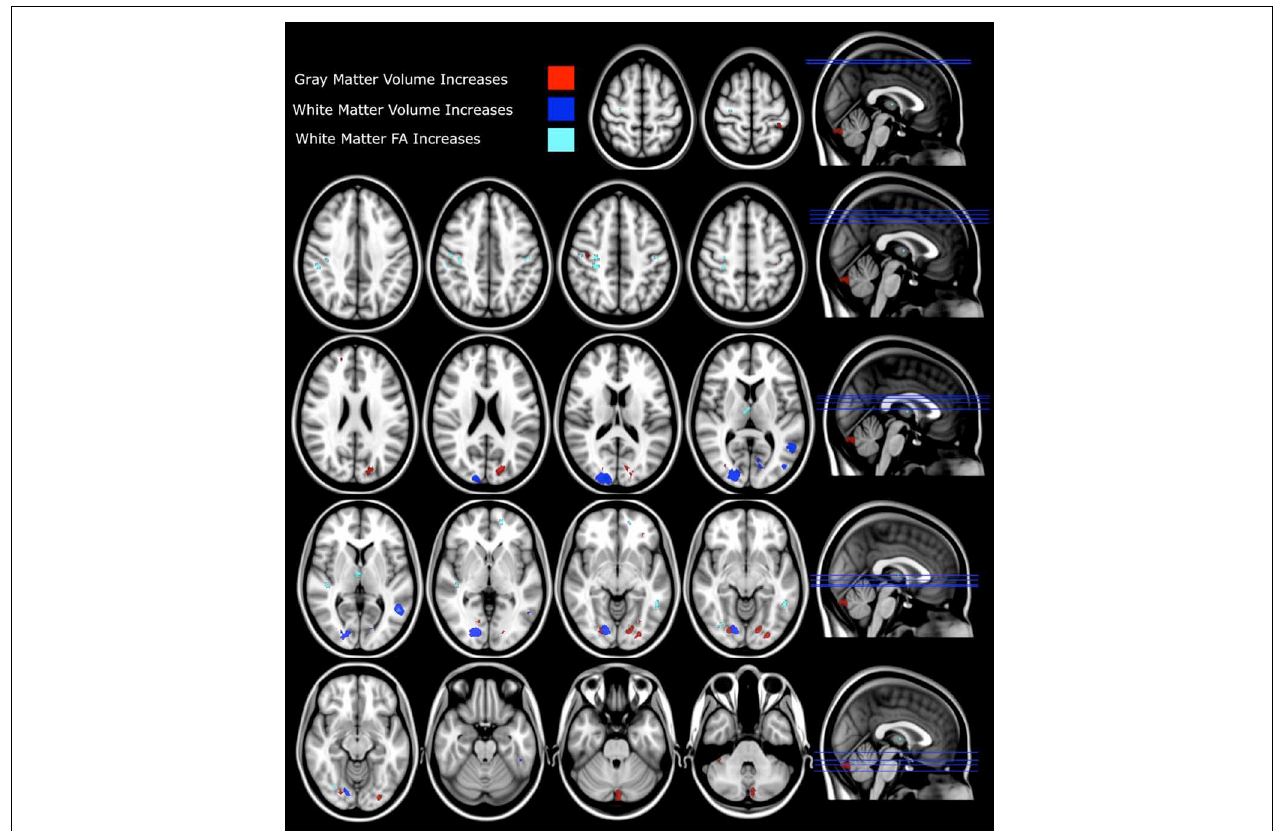
FIGURE 3 | Structural differences between synaesthetes and non-synaesthete controls. Whole brain VBM analysis results are shown with significant between-group differences ( p = 0 . 01 FDR corrected) for gray matter shown in red (refer to Table 1 ) and white matter ( p = 0 . 01 FDR corrected) shown in blue (refer to Table 2 ). The slice location of each volumetric difference is indicated on the right hand side of the image. In addition, significant